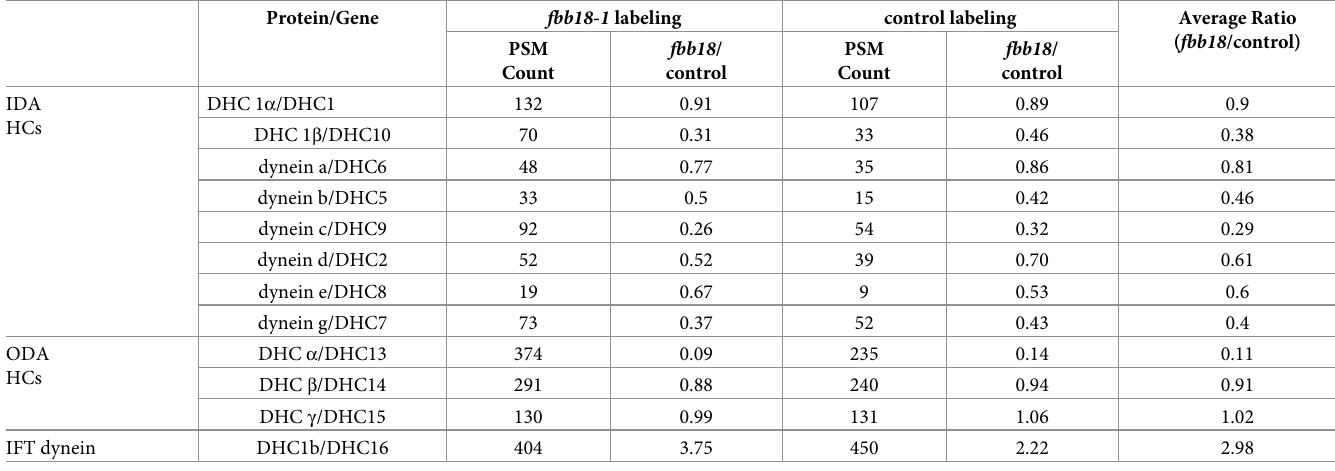
Table 1. Changes in protein abundance of axonemal dyneins in fbb18-1 versus rescued cells.